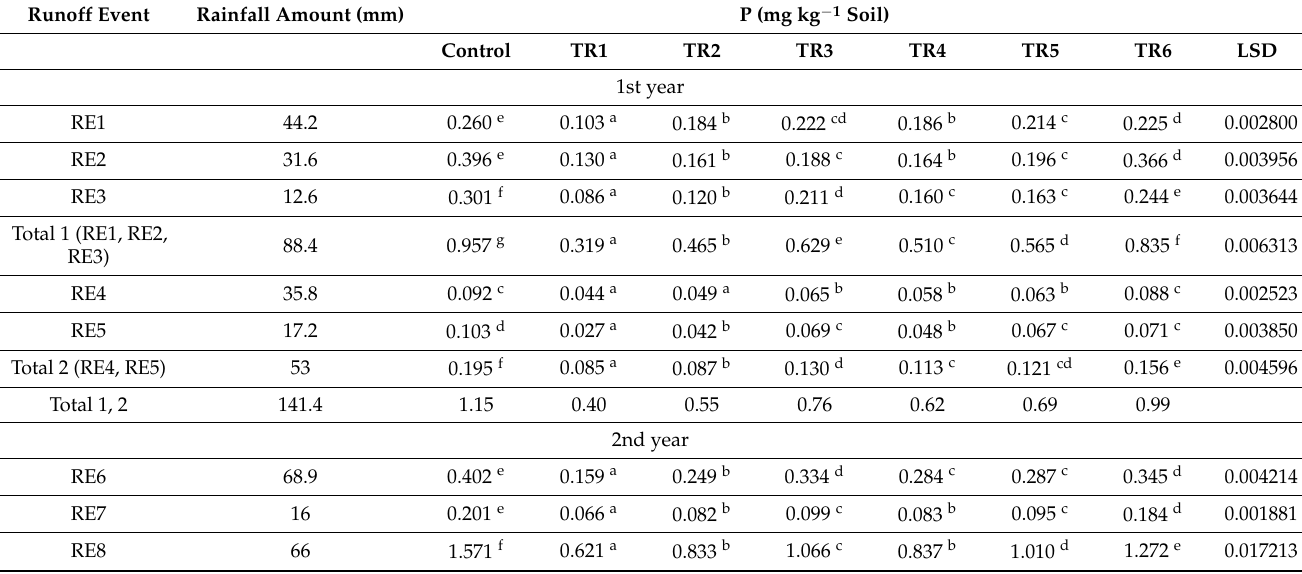
Table 8. Mean values of phosphorus loss (mg kg − 1 soil) in the seven treatments of the two cultiva- tion